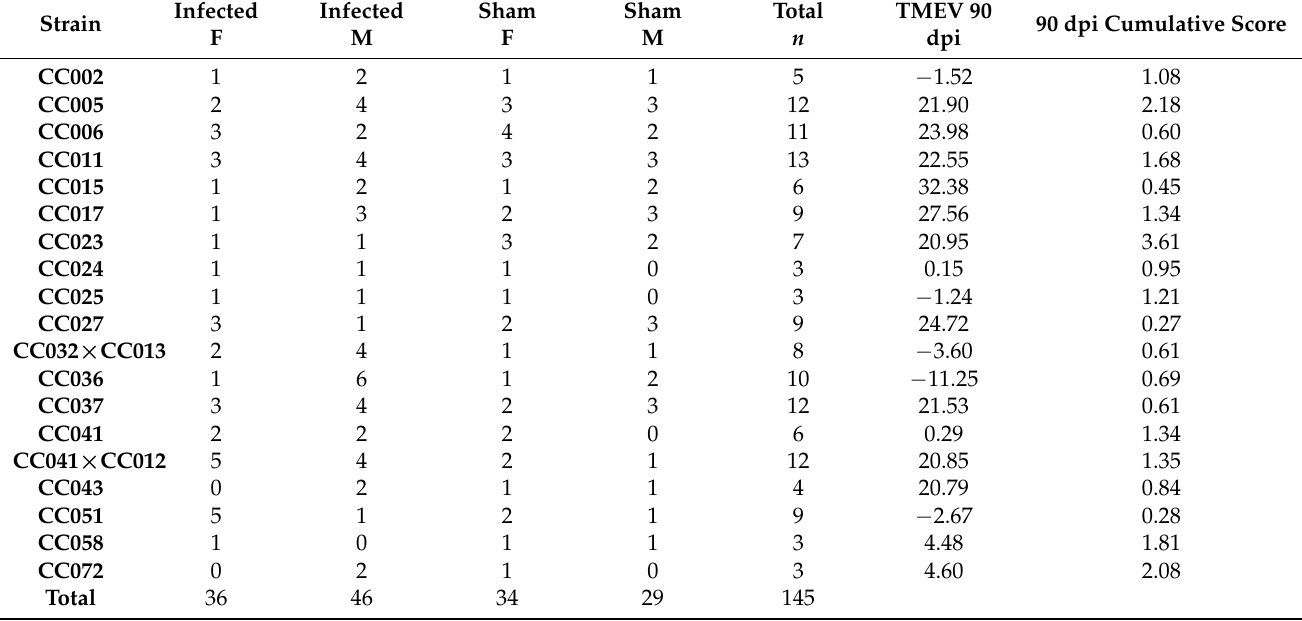
Table 4. Numbers of mice evaluated for each of 19 CC strains are shown, separated by sex and infection status. Average levels of TMEV RNA detected in infected mice at 90 dpi, compared to sham-infected mice of the same strain, are reported in the column “TMEV 90 dpi.” We considered negative values to indicate undetectable levels of TMEV RNA. The average 90 dpi cumulative scores for infected mice of each strain (as previously reported, [23]) are listed in the far-right column. Note that phenotypes of sham-infected mice were also evaluated, and used as baseline when scoring infected mice of the same sex and